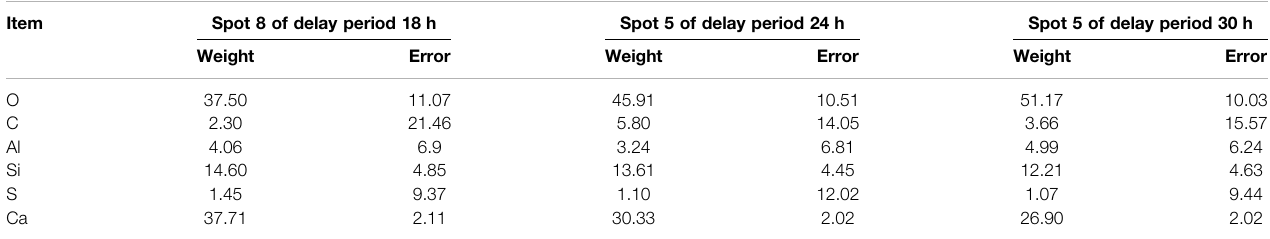
TABLE 7 | Elemental composition and mass fraction of hydration